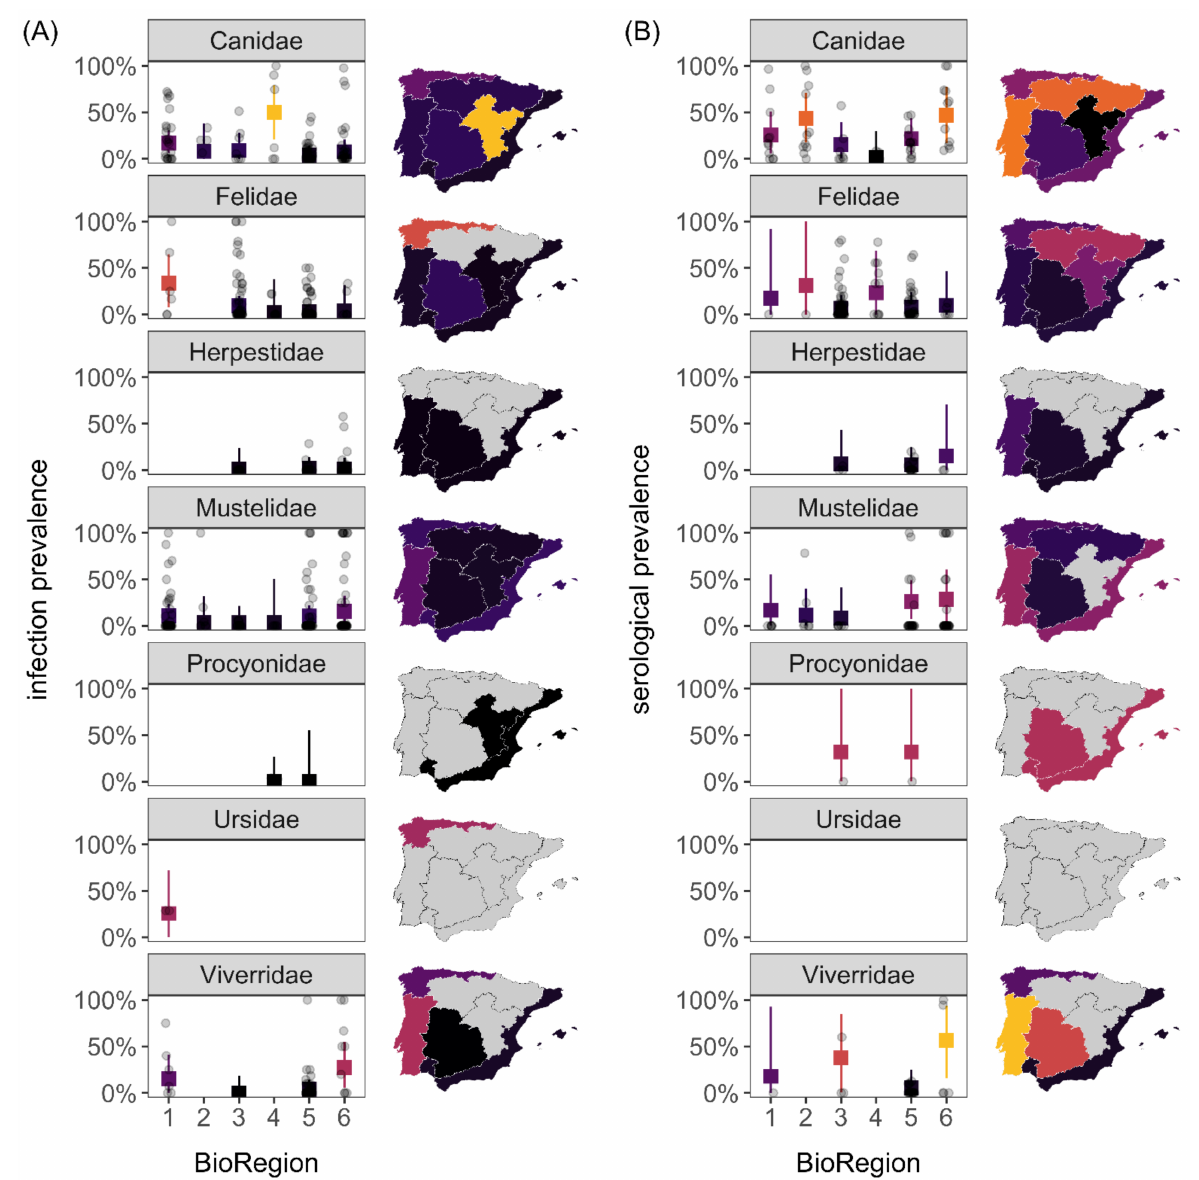
Figure 4. Infection prevalence ( A ) and seroprevalence ( B ) according to carnivore family and bioregion. Predicted means and 95% confidence intervals from meta-analysis models are shown with raw data. Choropleth maps display the predicted mean responses for bioregion averaged across carnivore